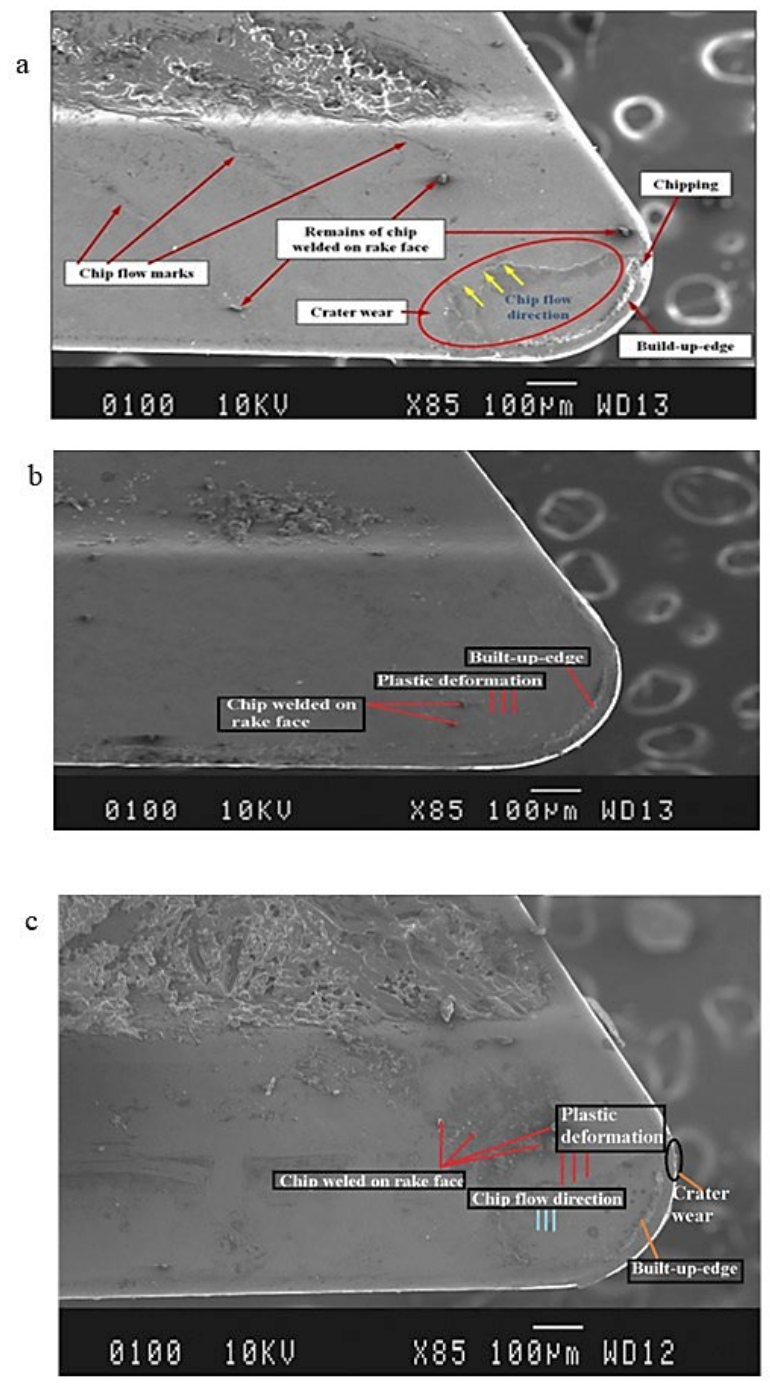
Figure 12. SEM pictures showing tool wear pattern for cutting speed of 150 m/min, ( a ) Dry; ( b ) RHVT; ( c ) Compressed air.